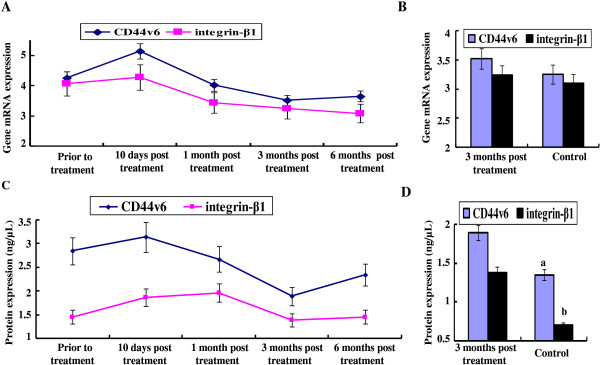
CD44v6 and integrin-β1 expression levels in patients prior to and after cryosurgery. (A) The trends of CD44v6 and integrin-β1 mRNA expression levels in patients after cryosurgery were observed. Bars indicate standard error (SE); (B) Differences of CD44v6 and integrin-β1 mRNA expression levels between control and patients in 3 months after cryosurgery were analyzed; (C) The trends of CD44v6 and integrin-β1 protein expression levels in patients after cryosurgery were observed; (D) Differences of CD44v6 and integrin-β1 protein expression levels between control and patients in 3 months after cryosurgery were analyzed (aP<0.05 and bP<0.05 stands for significant difference between two groups).